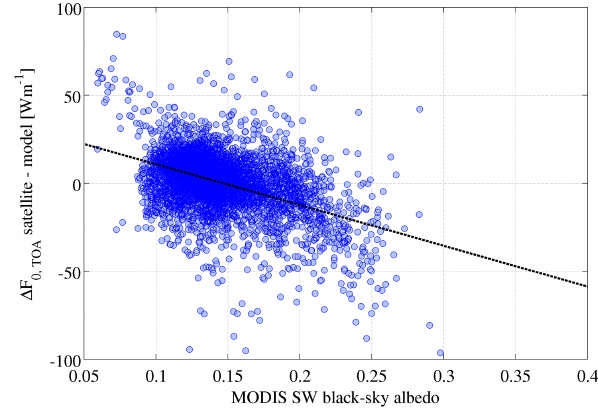
Figure 10. Differences between satellite-based and modeled F 0 , TOA as a function of the MODIS black-sky SW